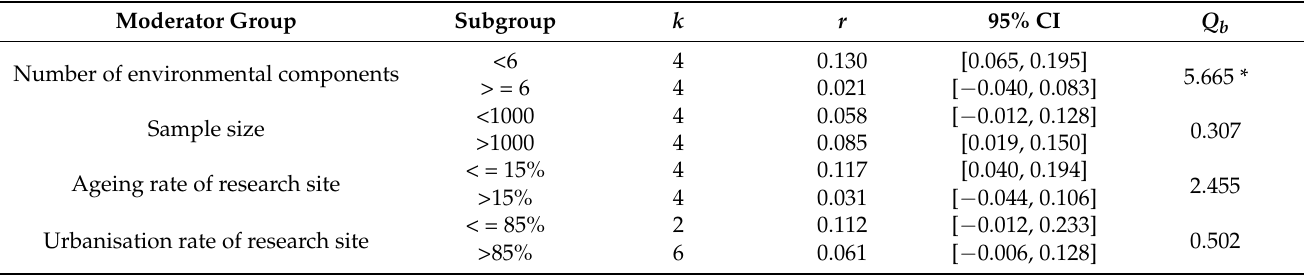
Table 2. Moderator analysis of the association between AFEs and physical well-being.